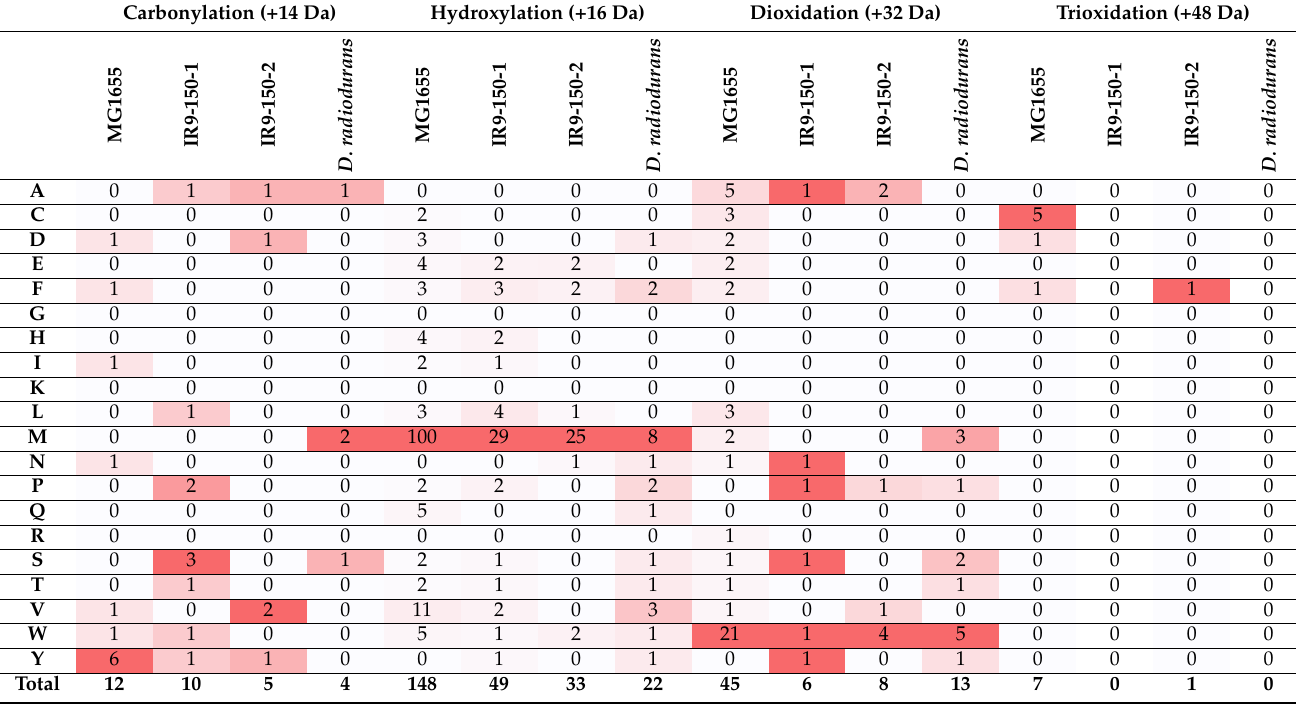
Table 6. Amino acid modifications on peptides exhibiting an increase in abundance.